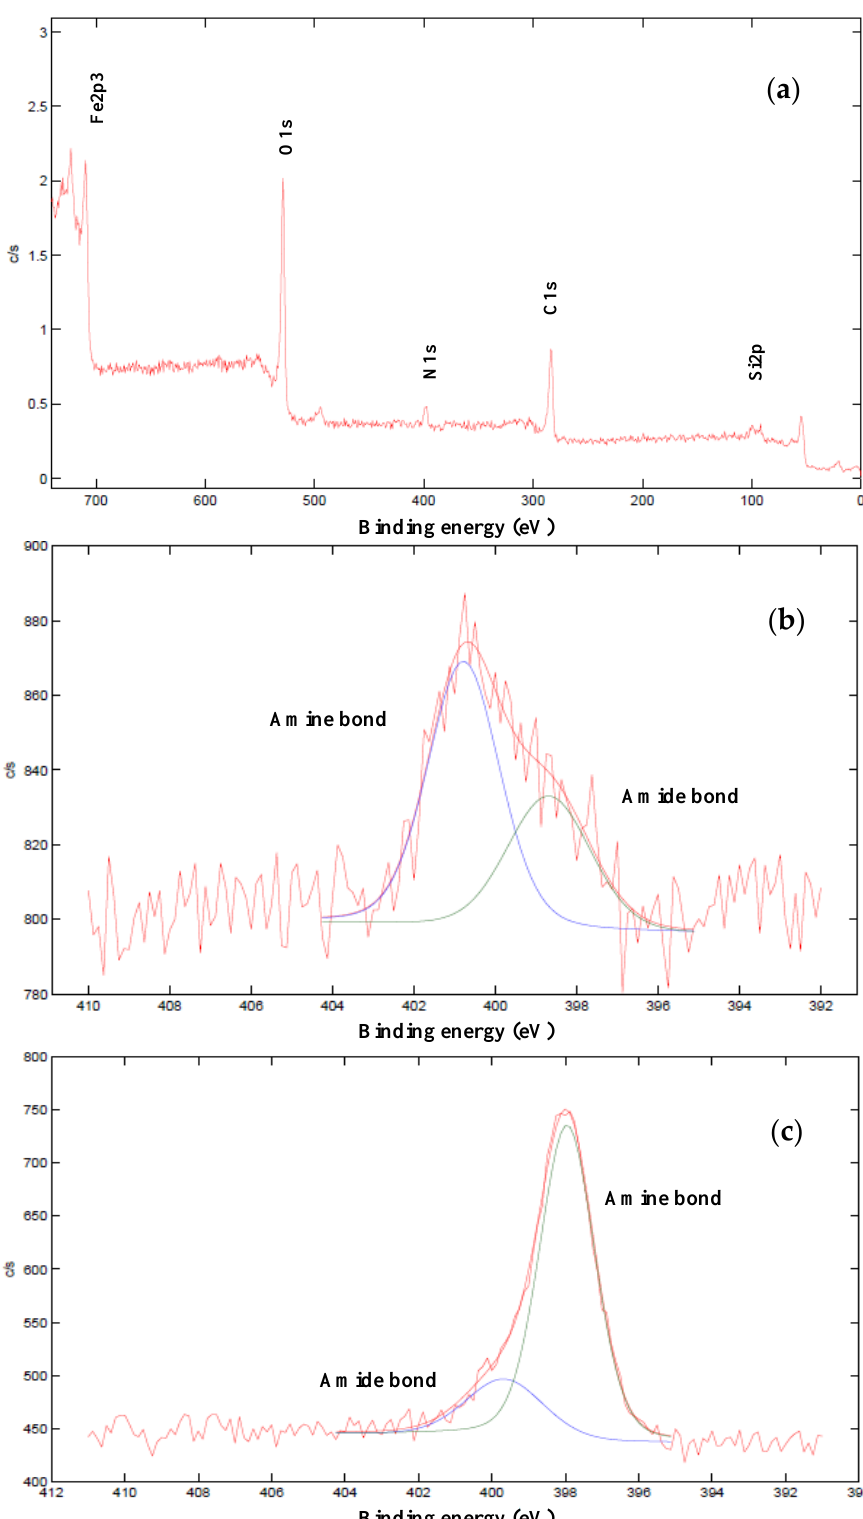
Figure 8. XPS spectra of Method 3: ( a ) EDA–MNPs–GO coupling; ( b ) deconvoluted XPS nitrogen spectrum of MNPs–GO coupling; and ( c ) deconvoluted XPS nitrogen spectrum of EDA–MNPs–GO coupling.